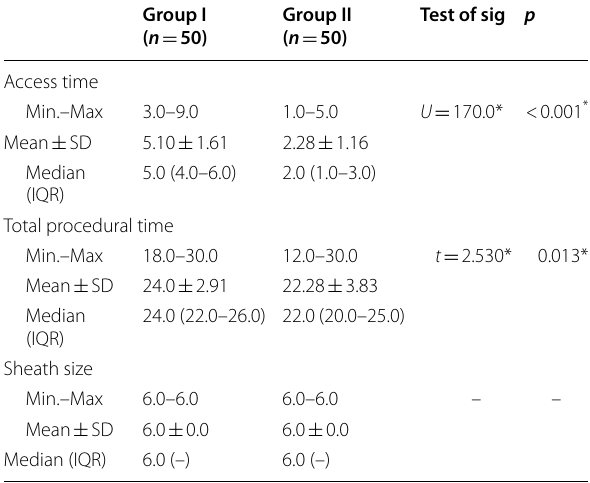
Table 5 Comparison between the two studied groups according to access time, total procedural time and sheath size